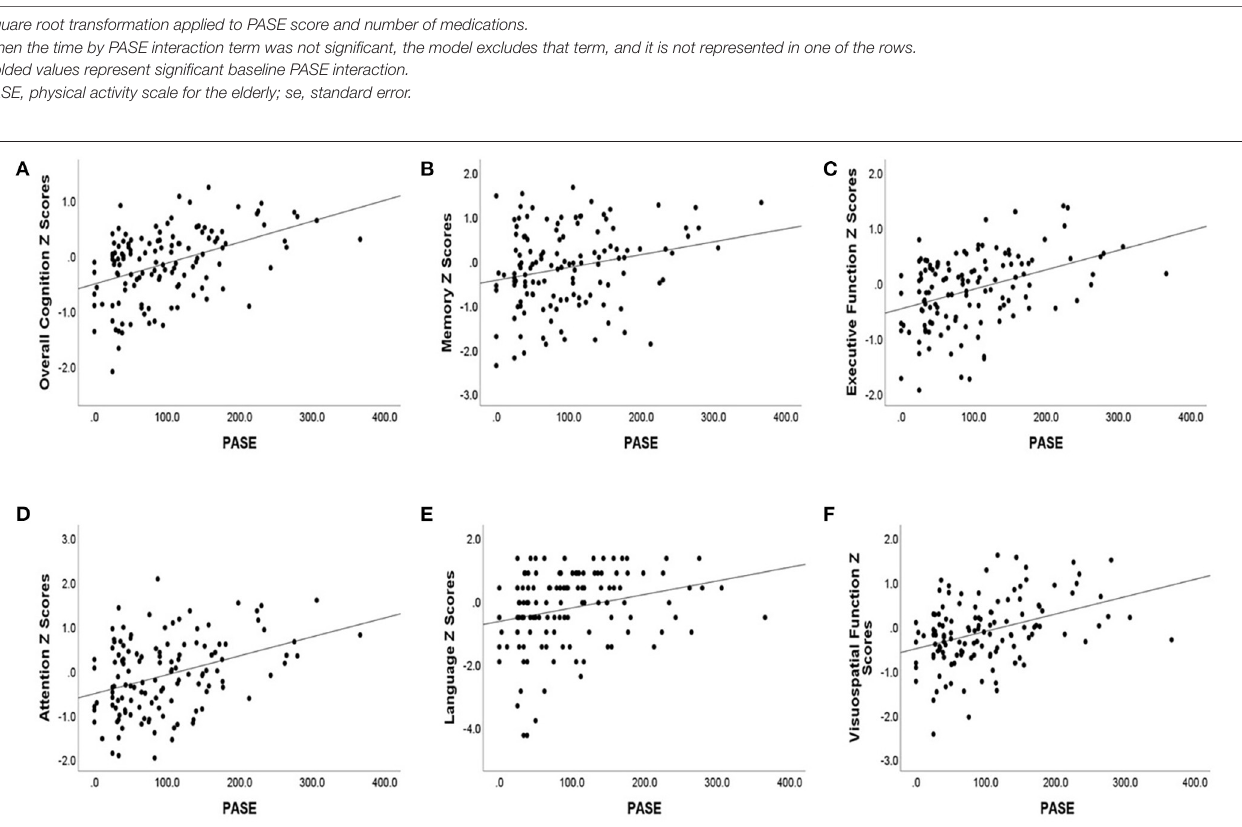
FIGURE 1 | Baseline cognitive Z scores [ (A) overall cognition, (B) memory, (C) executive function, (D) attention, (E) language, (F) visuospatial function] are plotted against baseline PASE score. Baseline cognitive scores are plotted against overall cognition and cognitive domain